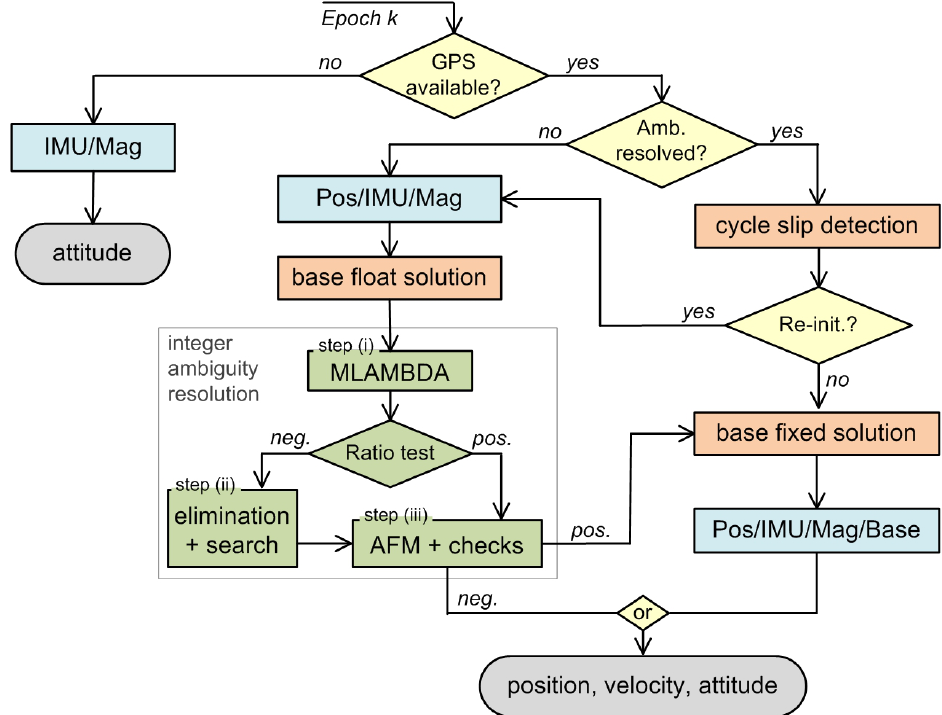
Figure 1. Flowchart of the attitude determination calculation steps. “Pos/IMU/Mag/Base” abbreviates a Kalman filtering, where a position measurement (Pos), IMU (inertial measurement unit) readings, magnetic field observations (Mag) and the GPS baseline (Base) are integrated. MLAMBDA is the modified LAMBDA method [33], and the AFM is the ambiguity function method